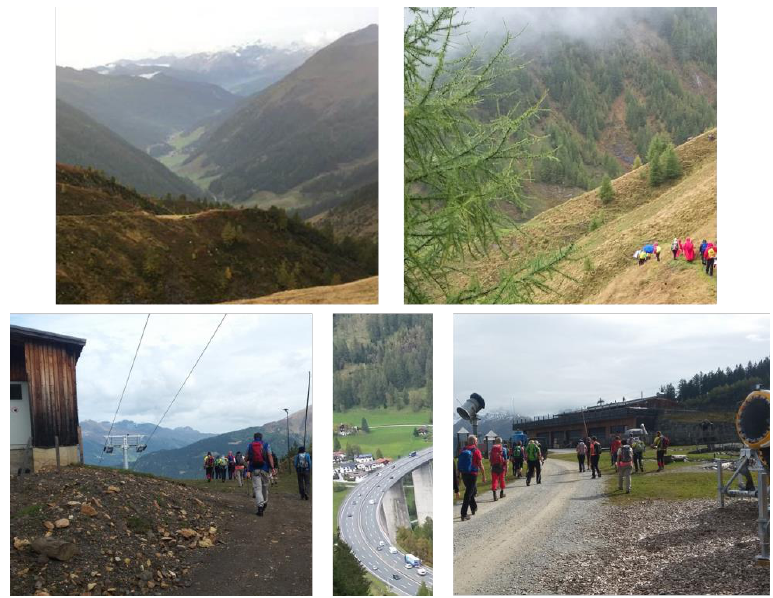
Figure 3. Typical view while hiking in the environment with less anthropogenic elements (N, two upper pictures) and the environment with more anthropogenic elements (H, three lower pictures).